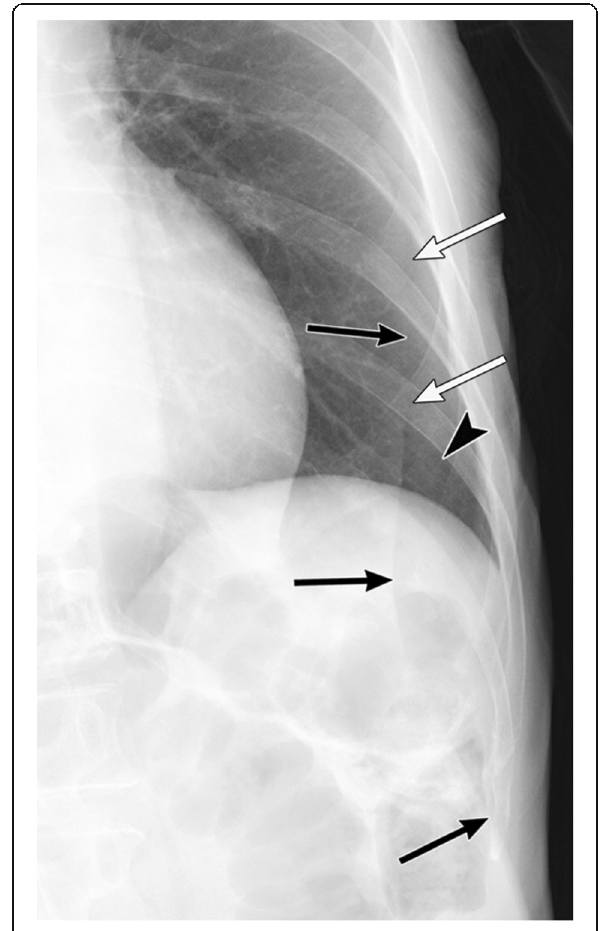
Fig. 8 A skin fold mimicking pneumothorax on a radiograph in a 66-year- old woman with glioblastoma. The skin fold appears as a broad radiopaque band (black arrows) that is adjacent to a radiolucent band (white arrows), which reflects a negative Mach band effect in the left lung field on a supine radiograph. It extends beyond the pleural cavity. Vascular markings (black arrowhead) are visible beyond its